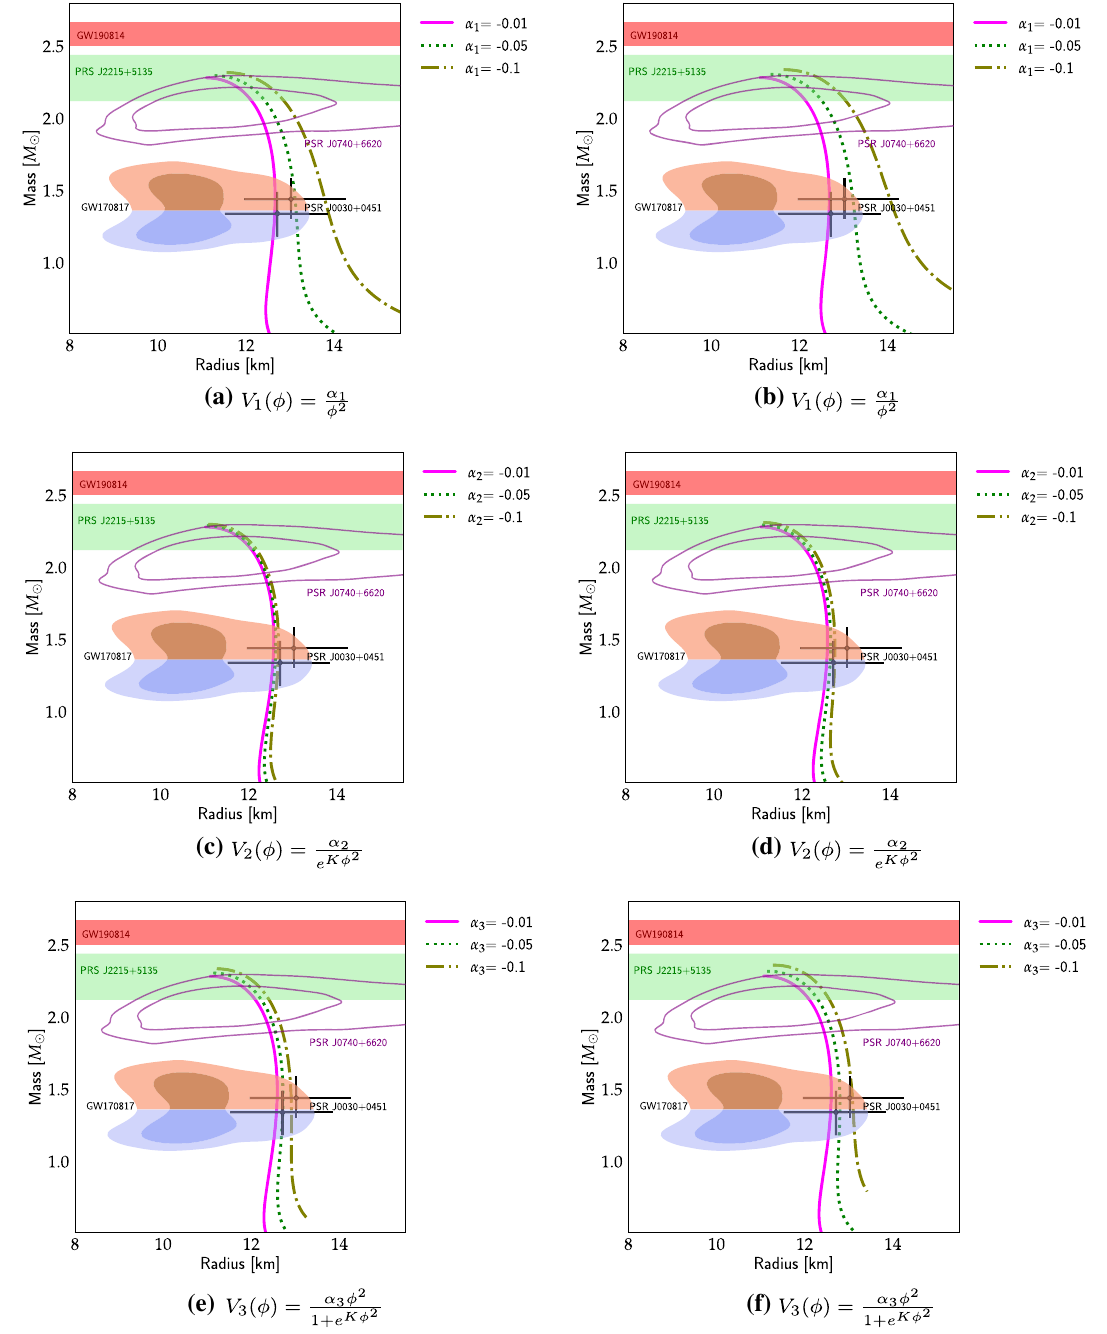
Fig. 4 The mass–radius relation of neutron stars in mimetic gravity for BSK21 EoS. φ( 0 ) = 1: left panels and φ( 0 ) = 0 . 8: right panels and K = 0 .